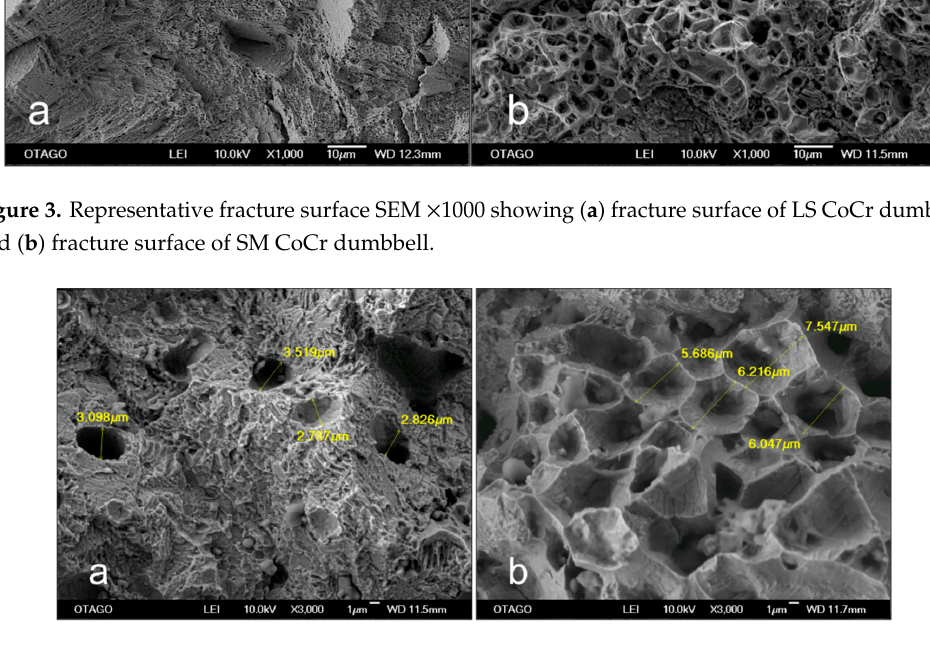
Figure 4. Representative fracture surface of SEM image at × 3000 ( a ) taken from the centre of the fracture surface, ( b ) taken from the area adjacent to the edge of the dumbbell. Despite similar magnification being used, the voids are larger at the edge of the dumbbell than at its centre.